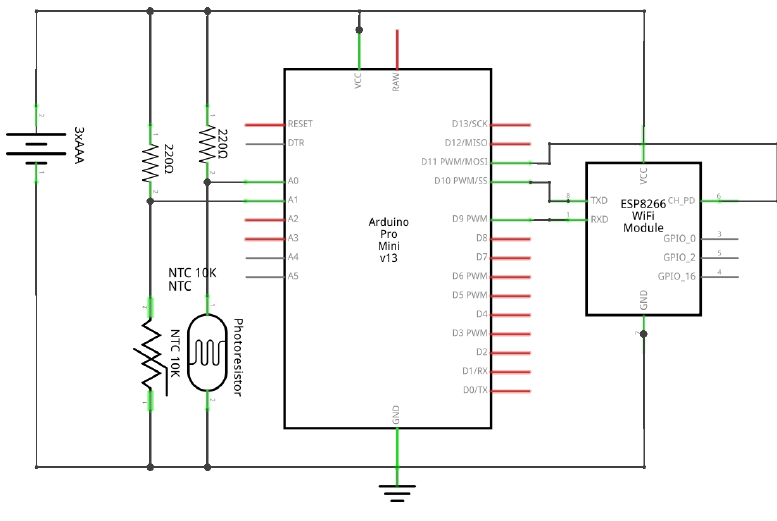
Figure 3. Schema of the sensor used in the evaluation prototype.